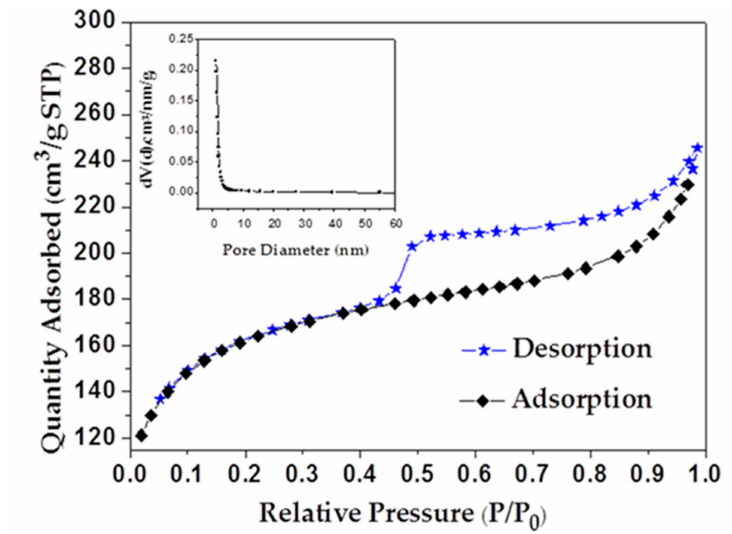
Figure 1. Curves of N 2 sorption isotherms and pore size distribution (inserted) calculated from the density functional theory for activated kelp biochar (AKB). (* STP represents a temperature of 0 ◦ C (273.15 K) and a pressure of 101.325 KPa (1 standard atmosphere, 760 mm Hg). P represents the vapor pressure on the meniscus with a temperature T and a radius of curvature r; P 0 represents the saturated vapor pressure on a flat liquid of temperature T). Table 1. Main metal elements of AKB obtained by inductively coupled plasma (ICP), mg/kg. Metal Elements